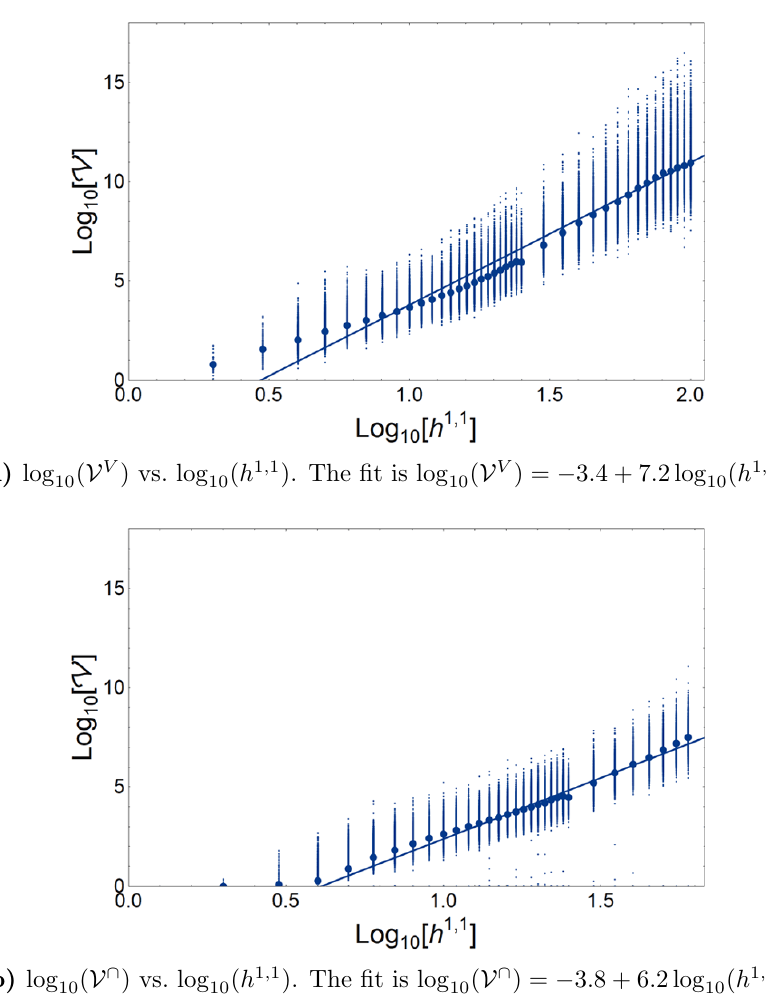
Figure 8. Lower bounds on V , de(cid:12)ned in (2.7), vs. h 1 ; 1 in g K V (top) and f K \ (bottom).